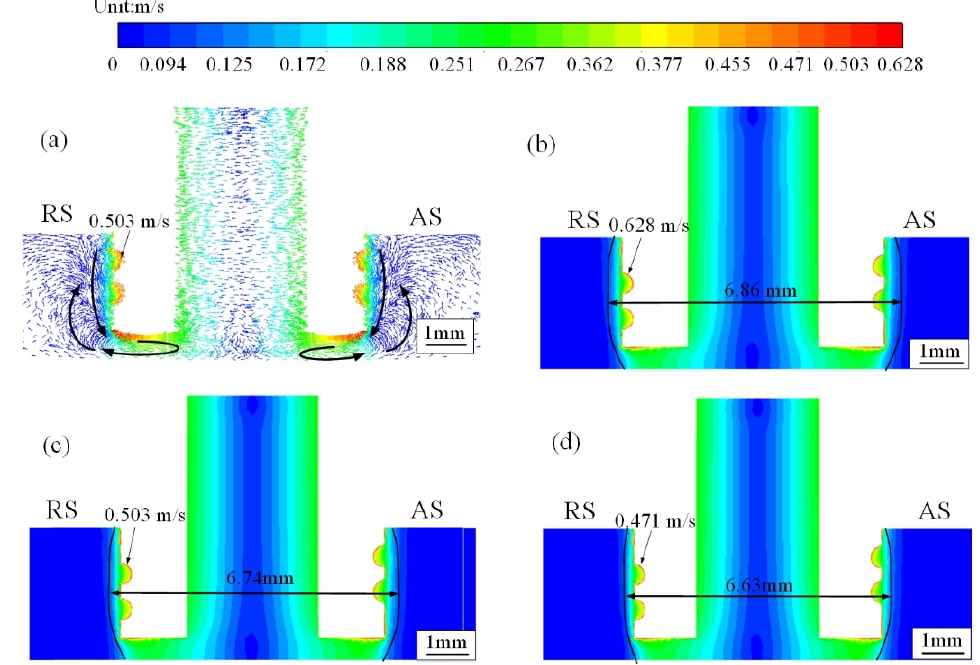
Figure 5. ( a ) Material flow velocity vectors at 150 mm/min welding speed; material flow contours at ( b ) 110 mm/min, ( c ) 150 mm/min and ( d ) 190 mm/min welding speeds.